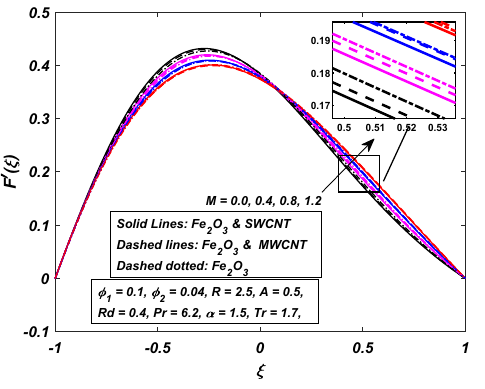
Figure 8. Influence of M on F ′ (ξ) .